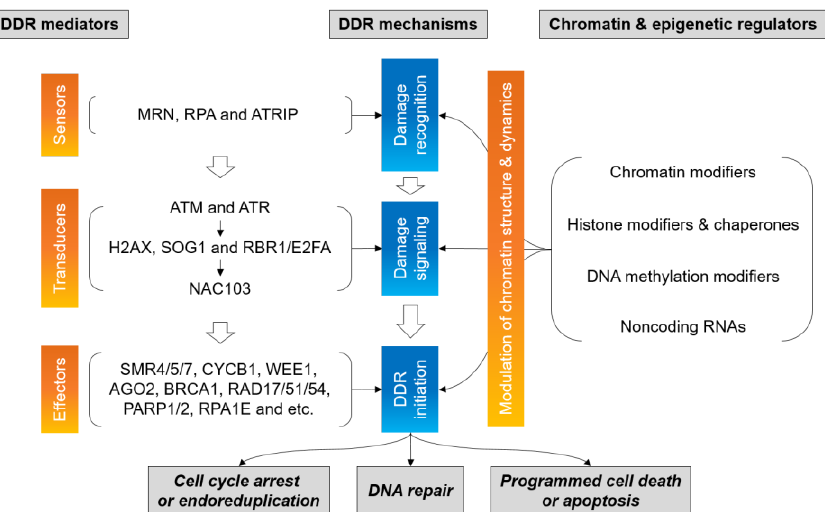
Figure 1. Signaling pathway of DNA damage response (DDR) in the context of chromatin. Chromatin structure and dynamics are regulated by chromatin remodeling and epigenetic modifications to mediate DNA damage recognition, signaling, and repair.